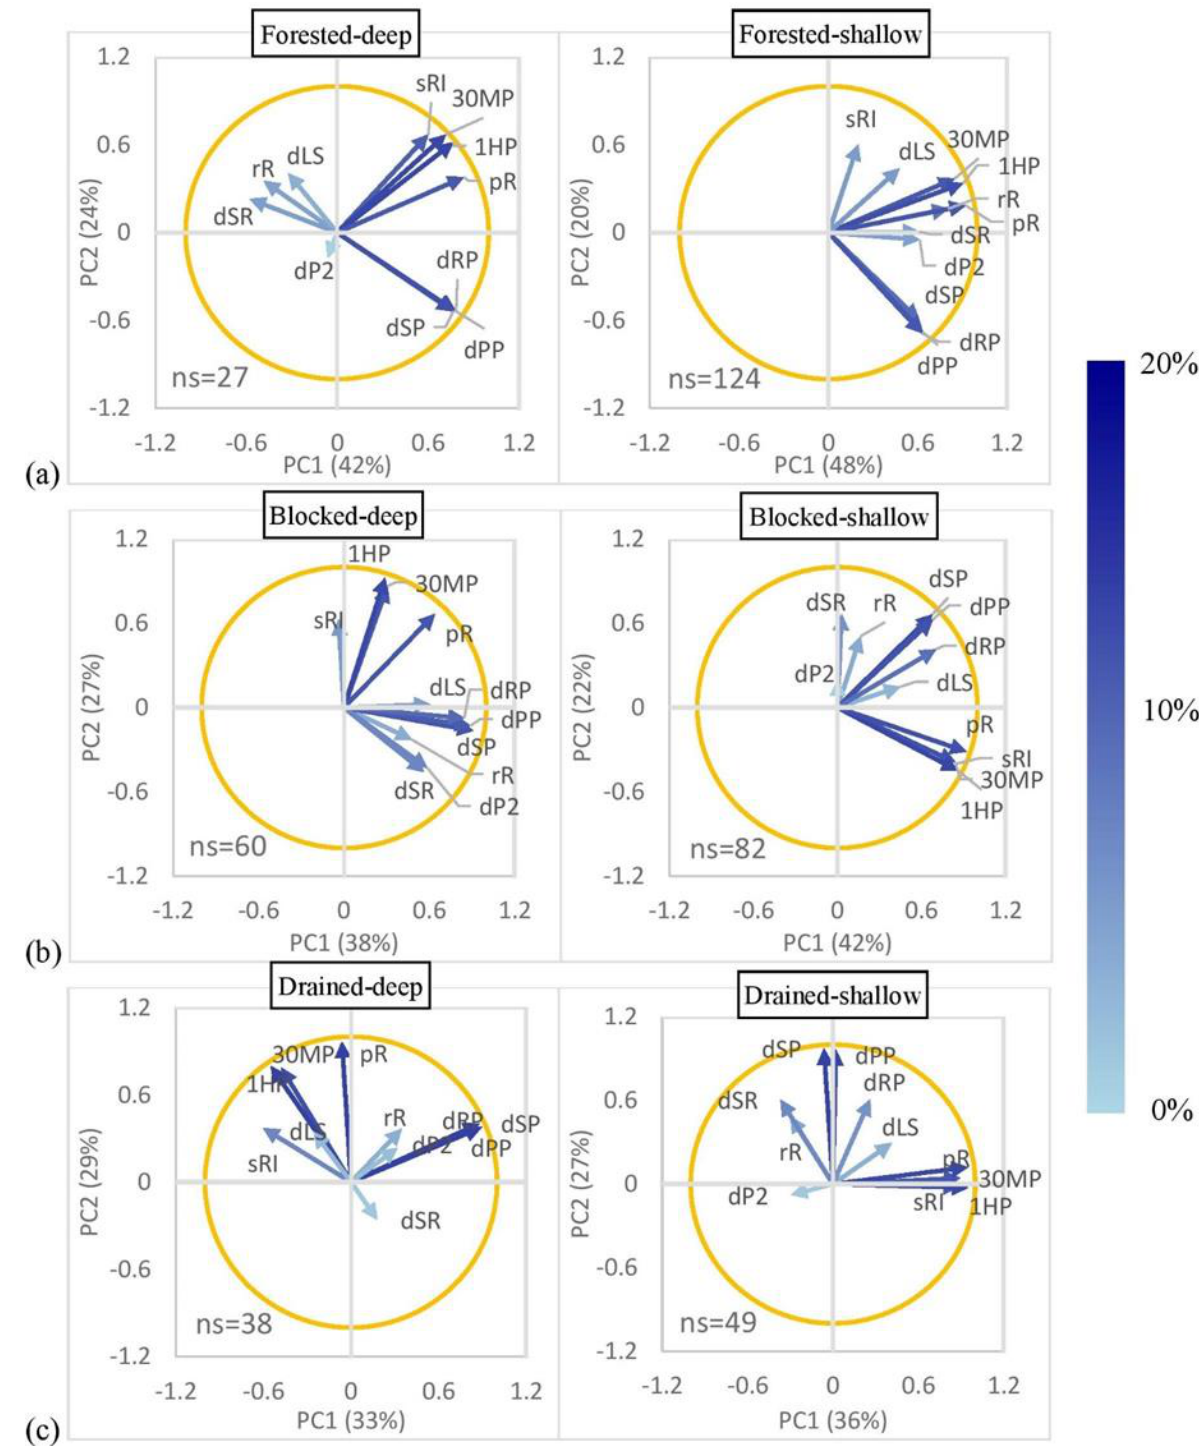
Figure 3. Principal Components 1 and 2 (PC1 and PC2) with the distribution of each hydrological variable for the three sites. The variable codes are provided in Table 1. The left-hand panels show the variations under deep water-table conditions (deep/dry period), while the right-hand panels show the shallower water-table conditions (shallow/wet period). The percentage attributed to the axes indicates the variance that is represented by the PC. The arrows show the direction and the quality of representation for each variable to PC1 and PC2 within the maximum quality radius of 1 (yellow circle). The colour of the arrows shows the contribution of each variable to PC1 and PC2, in which the shaded bar indicates the percentage of the contributions. The number of storms (ns) used in the analysis for each location is